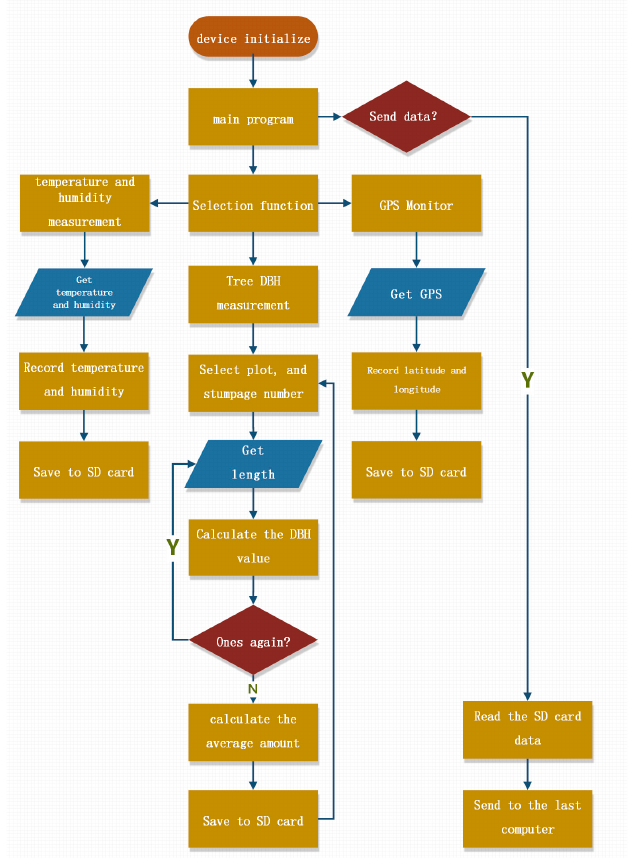
Figure 4. Software flow